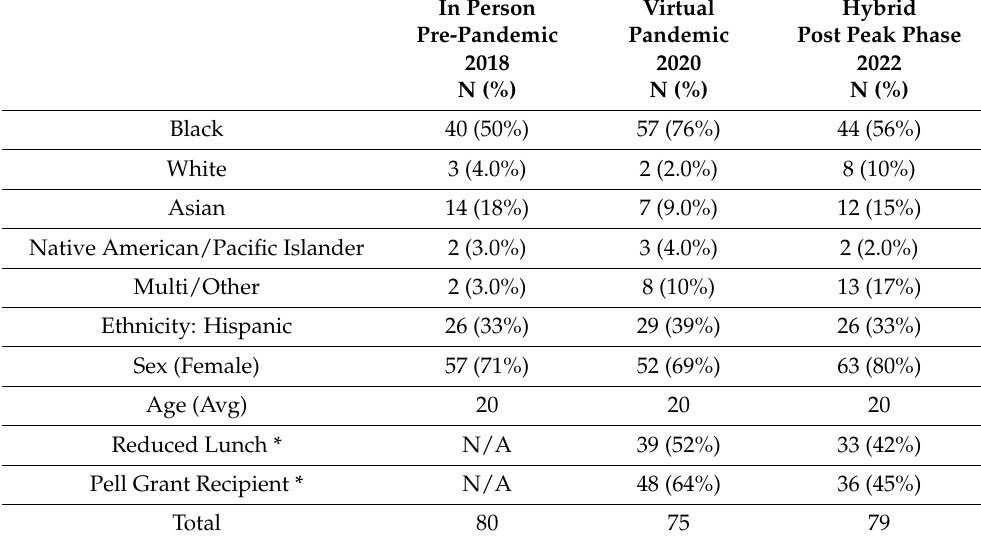
Table 1. Participant